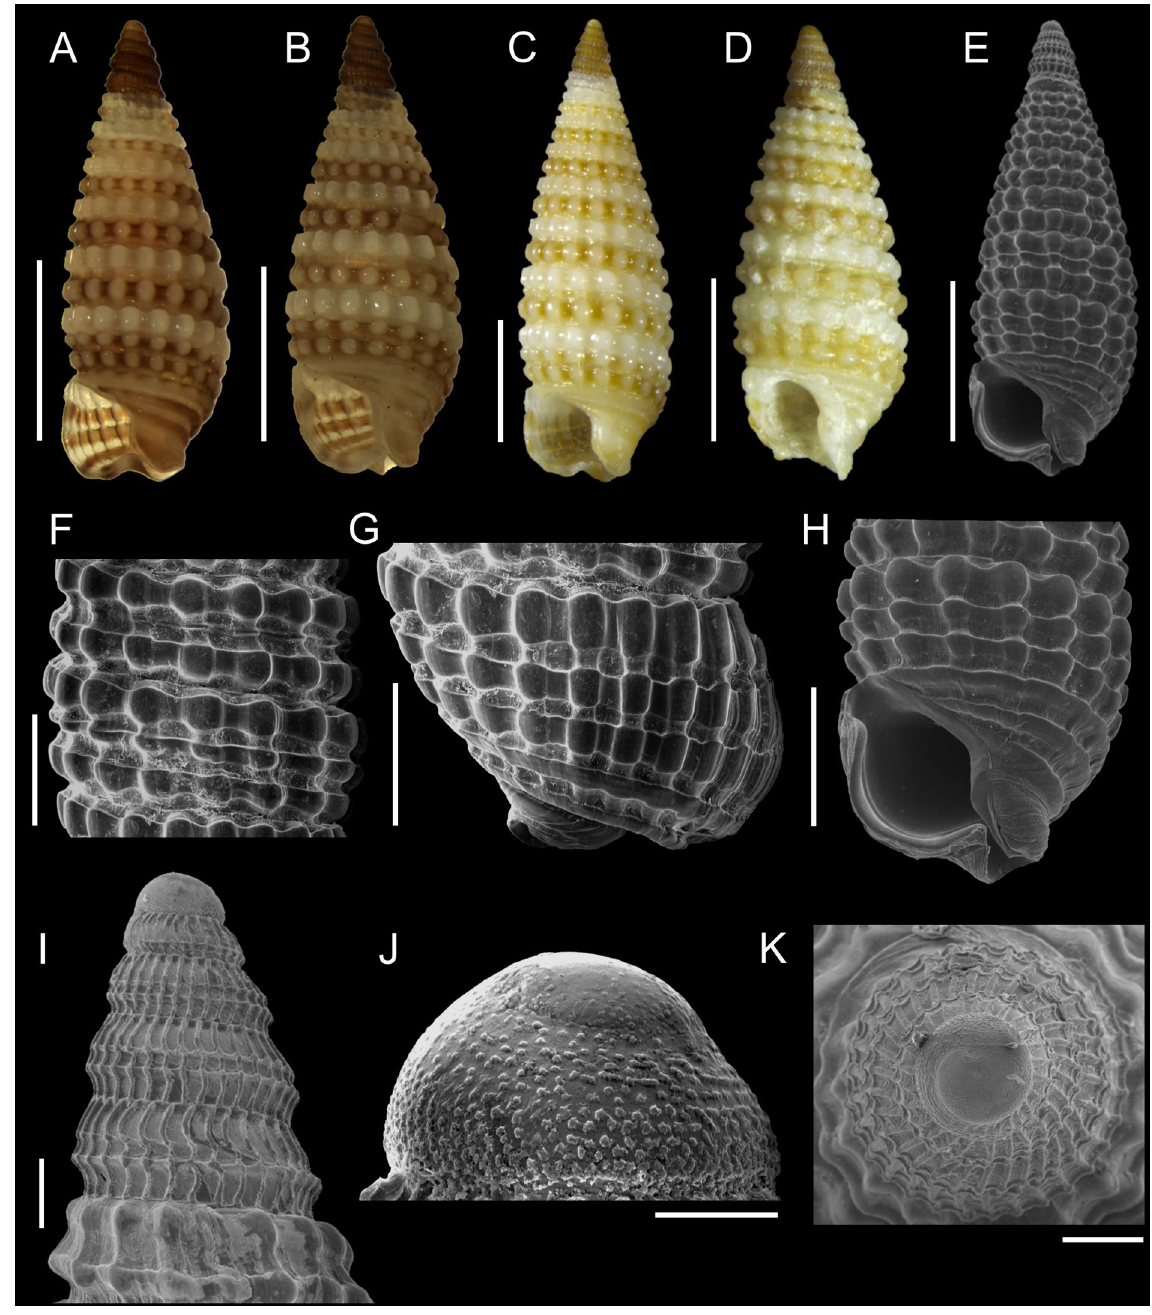
Fig. 96. Triphora ellyae De Jong & Coomans, 1988. A–B . MNRJ 15400*, 2.56 mm and 2.64 mm, respectively. C . MNRJ 32619*, 3.80 mm. D . UERJ 3840, 2.80 mm. E . MNRJ 18955*, 2.86 mm. F–H, J–K . Same shell as E. I . MNRJ 18626*. Scale bars: A–E = 1 mm; F–H = 500 µm; I, K = 100 µm; J = 50